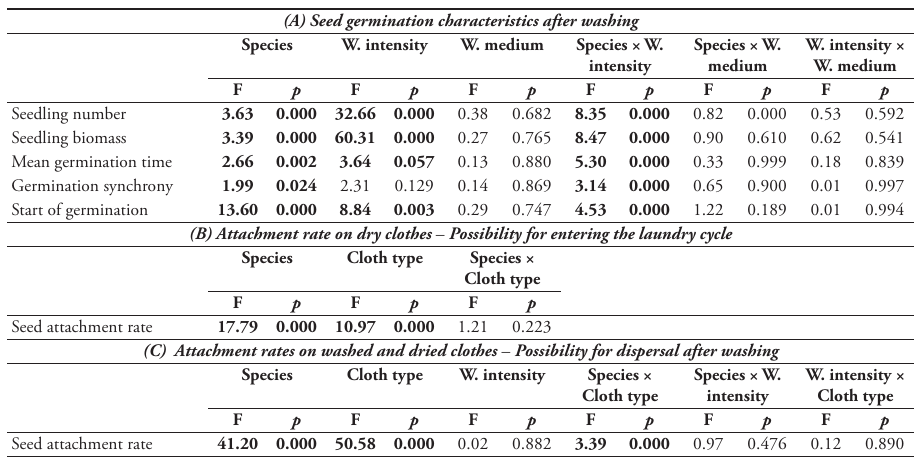
Table 2. The results of generalised linear models (GLM) fitted on (A) the relative response index (RRI) calculated for the germination characteristics after washing, (B) the attachment rates of propagules on dry clothes and (C) the attachment rate of washed propagules on washed and dried clothes. Significant effects are marked with